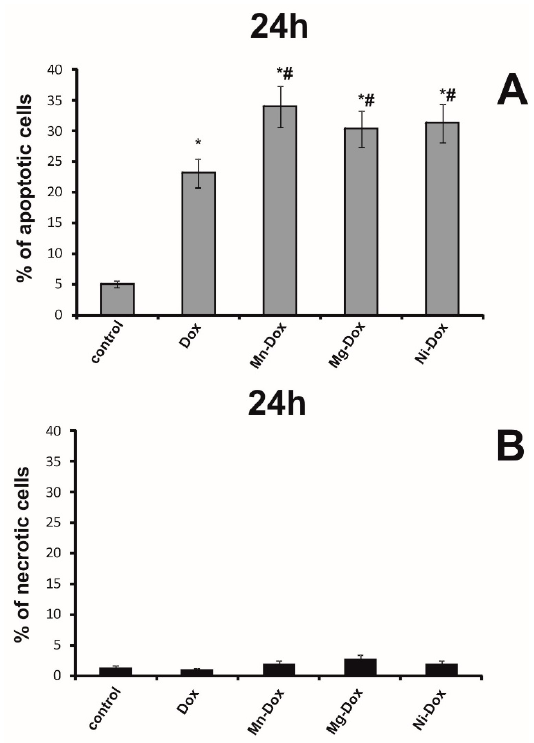
Figure 11. The effect of DOX, Ni-DOX, Mn-DOX and Mg-Dox on apoptosis of MCF-7 cells. The cells were incubated with 0.5 µM DOX, Ni-DOX, Mn-DOX and Mg-DOX for 24 h. Bar graphs presenting the percentage of apoptotic MCF-7 ( A ) and necrotic MCF-7 ( B ) cells, are demonstrated. Mean values from five independent experiments ± SD are shown. Significant alterations are expressed relative to control and marked with asterisks (*); significant alterations are expressed relative to DOX-control and marked with crosses (#). Statistical significance was considered if *# p < 0.05 .